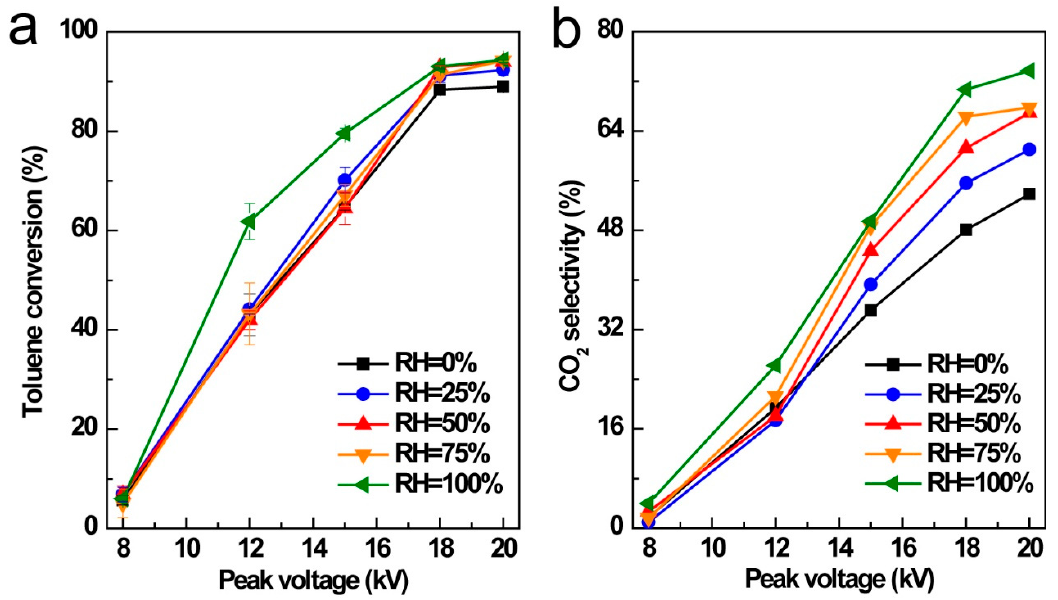
Figure 7. Influence of relative humidity on toluene conversion ( a ) and CO 2 selectivity ( b ).